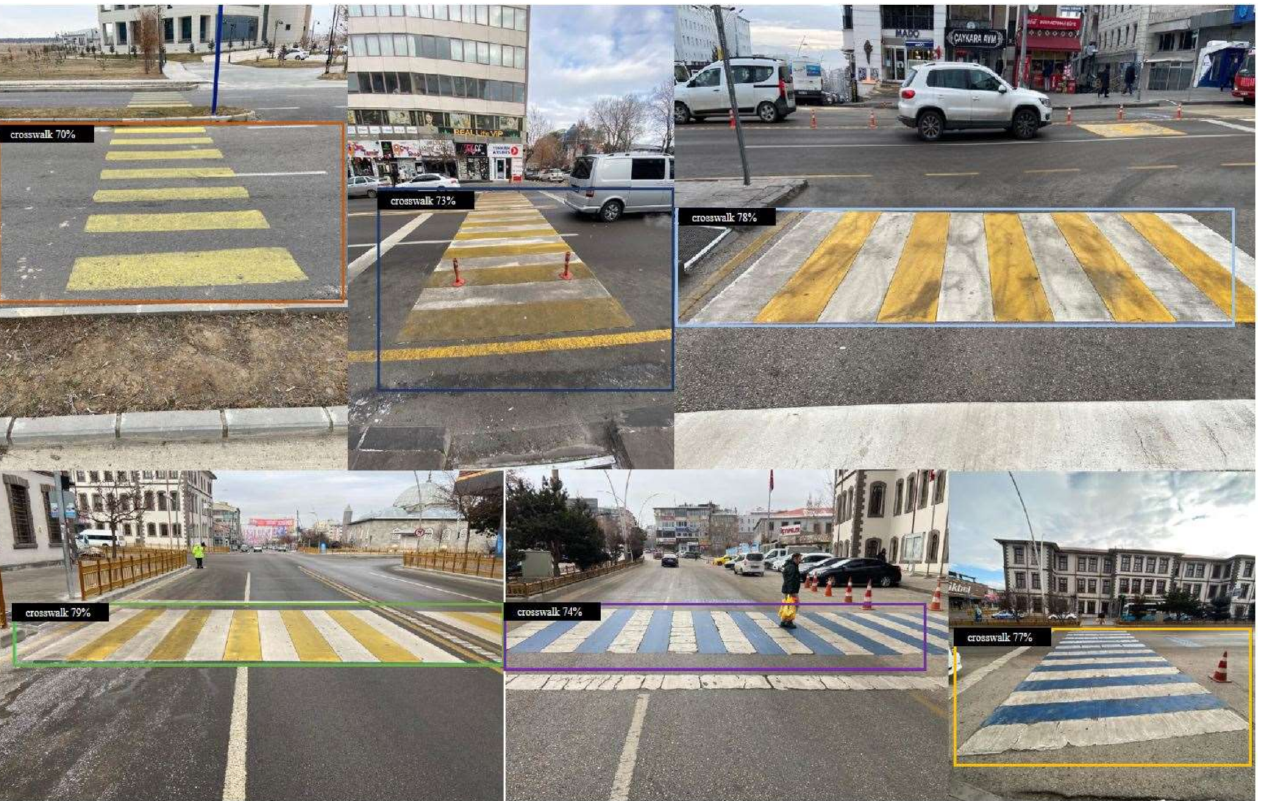
Figure 6. Detected “Pedestrian Crosswalk” from the CRWALKval dataset using Faster